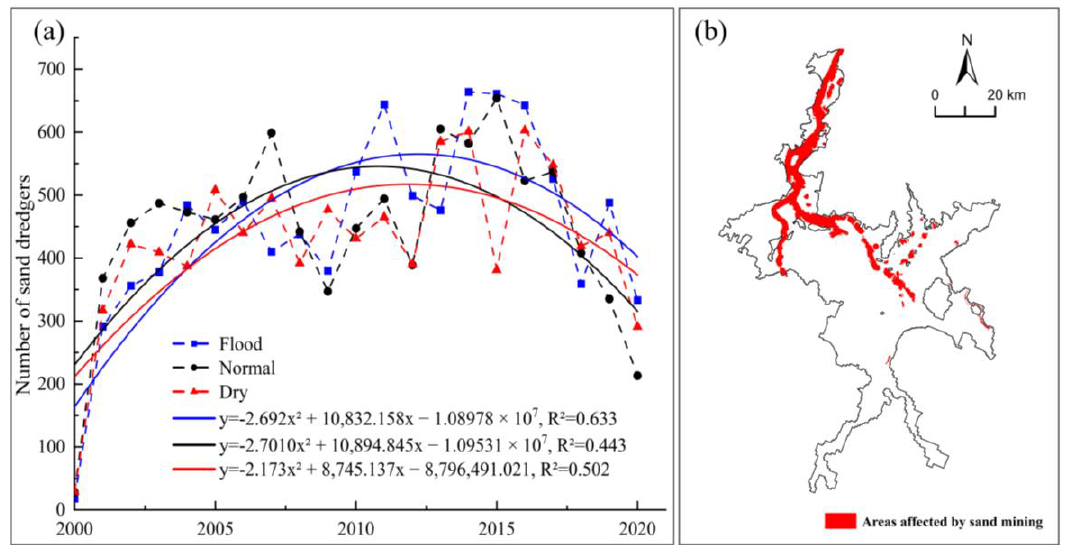
Figure 3. ( a ) Quadratic fits to the number of sand mining vessels in the past 20 years in each season; ( b ) Areas affected by sand mining